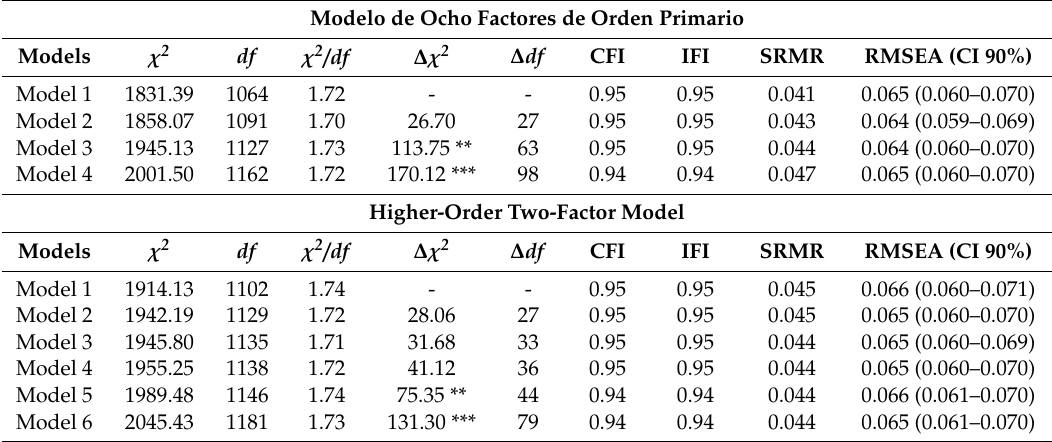
Table 2. Multi-group Age Invariance